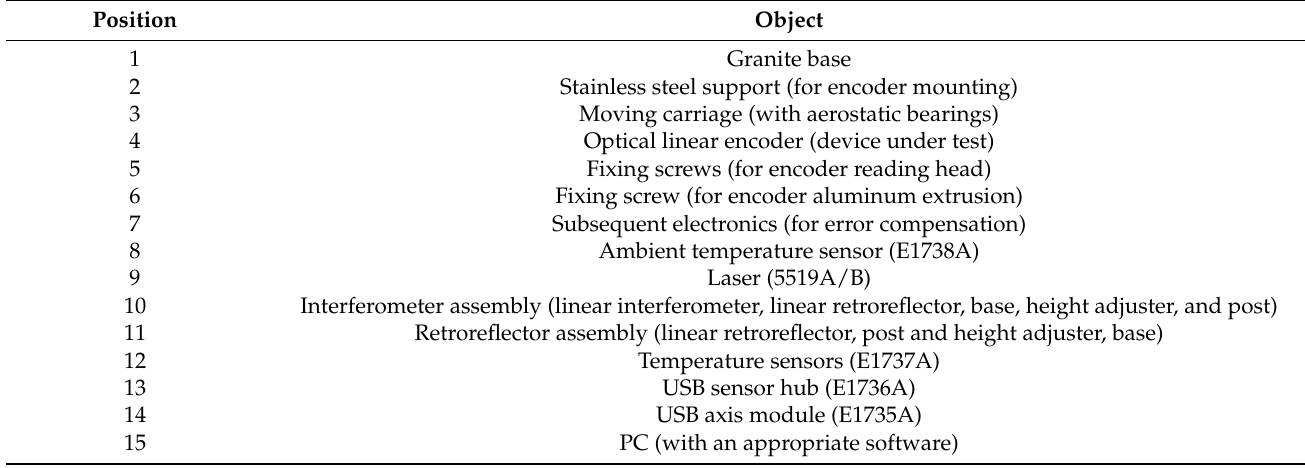
Table 2. Content of the experimental